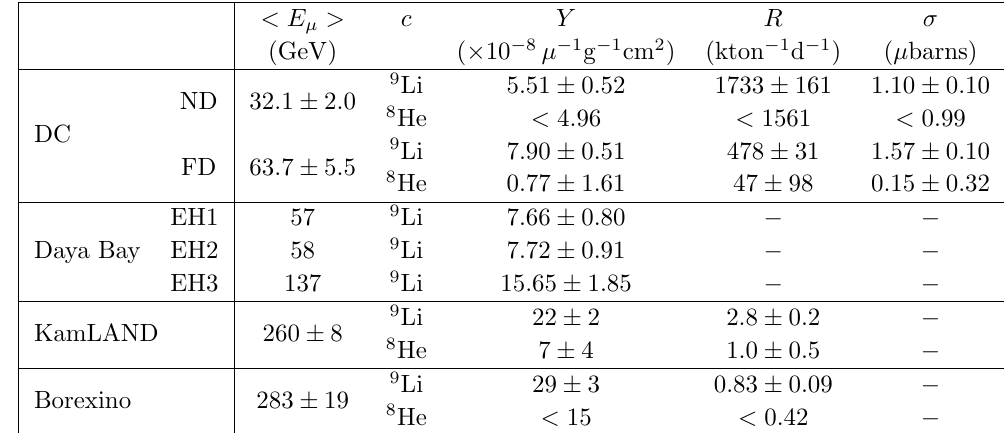
Table 2 . The yields Y , production rates R , and cross sections for 9 Li and 8 He produced in the ND and FD along with the corresponding mean muon energy < E (cid:22) > . In the ND case the 9 Li values are calculated for f He = 0% and a 3 (cid:27) upper limit is given for the 8 He values. The same values are given for Daya Bay [20, 21], KamLAND [3], and Borexino [4] where available and any limits are given at 3 (cid:27) . The Daya Bay 9 Li yields are calculated under the assumption that the measurements of their (cid:12) - n emitters are composed purely of 9